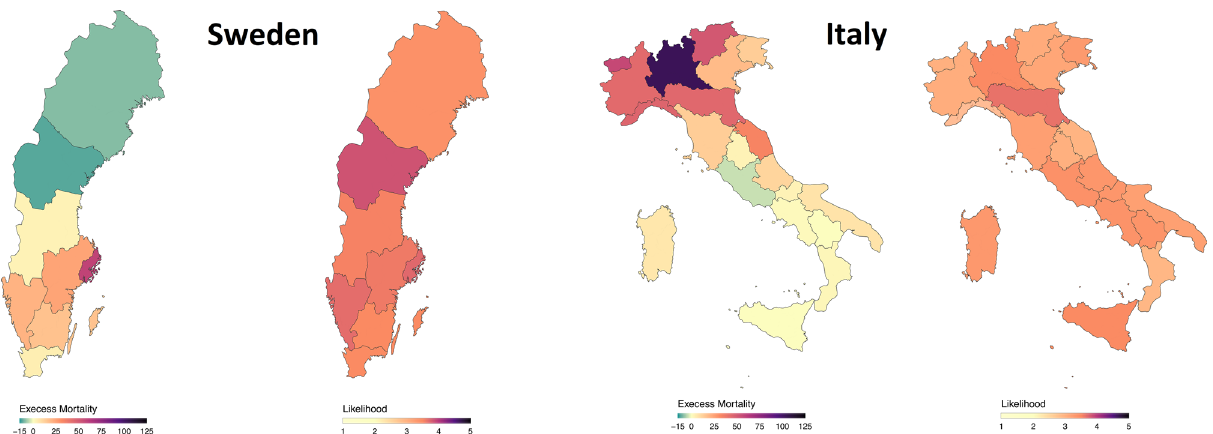
Figure 4. Perception of likelihood of epidemics after the first wave (August survey) and excess mortality during the first wave (15th February–15th May for Italy and 1st March–31st May for Sweden) stratified by region level. The figure was generate using R program and Inkscape (author: